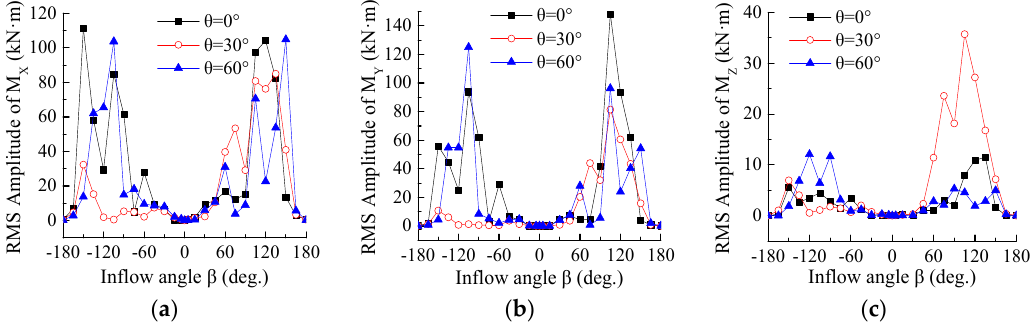
Figure 17. RMS amplitude of the total aerodynamic moments of the wind rotor: ( a ) The wind torque M X ; ( b ) The pitching moment M Y ; ( c ) The yawing moment M Z .